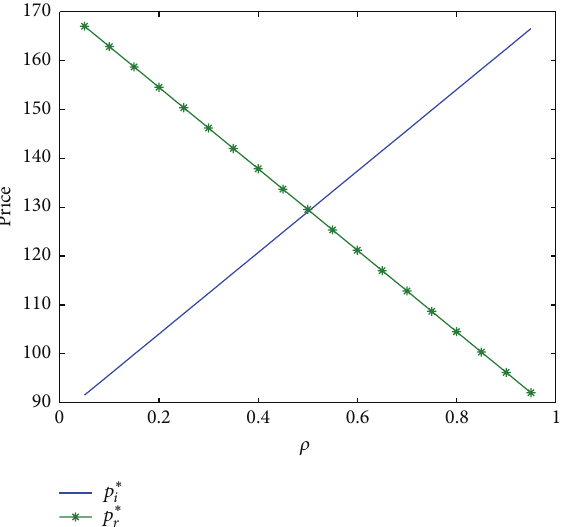
Figure 3: Impact of 𝜇 on pricings under demand certainty and uncertainty.